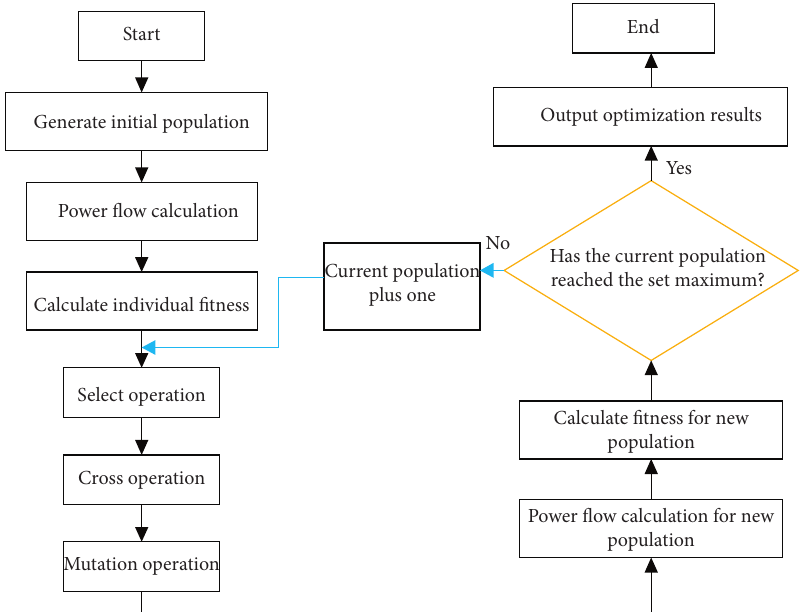
Figure 4: The solution process of genetic